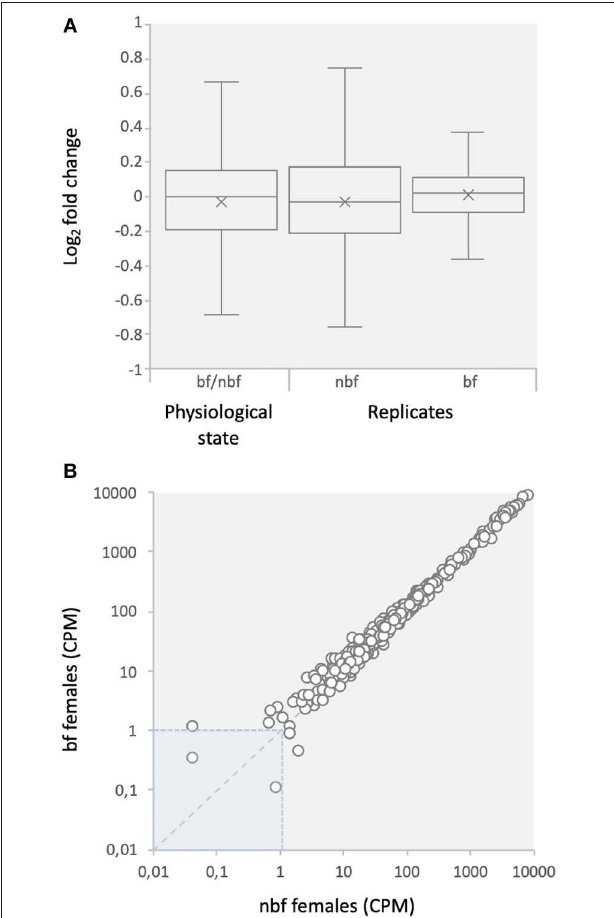
FIGURE 1 | Expression of core eukaryotic genes (CEGs). (A) Comparison of fold changes between blood fed (bf) and non-blood fed (nbf) female mosquitoes, and between replicates of the maxillary palp transcript libraries of Aedes aegypti . (B) Comparison of counts per million (CPM) between bf and nbf